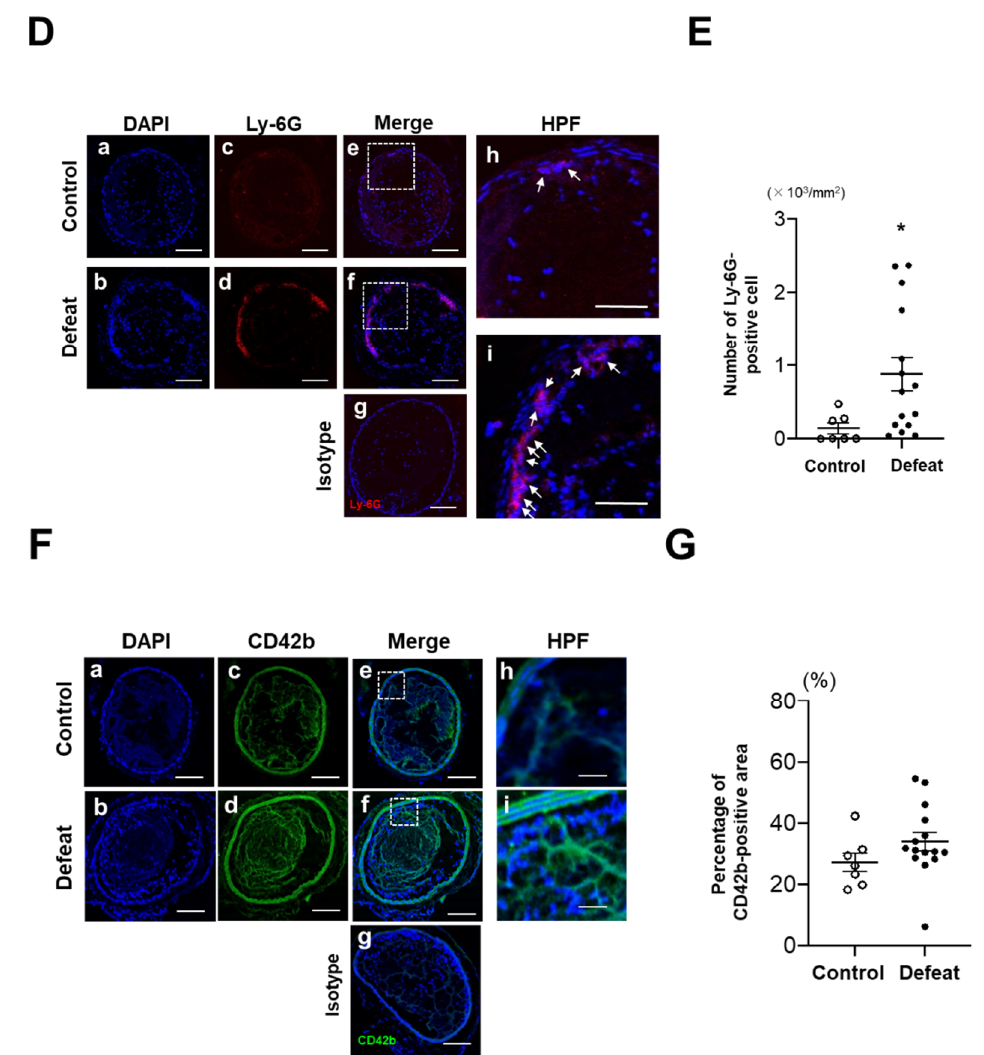
Figure 2. RSD exaggerates the development of fibrin-rich clot formation after FeCl 3 application. ( A ) Representative photographs of hematoxylin and eosin staining in control and defeated mice. Scale bar = 100 μm ( a , b ), 50 μm ( c , d ), and 20 μm ( e , f ). High magnification images ( e , f ) showing the area surrounded by a broken line in panel c , d , respectively. LPF, low-power field; HPF, high-power field. ( B , C ) Representative fluorescent images of fibrin(ogen) and quantitative analysis of the percentage of fibrin(ogen)-positive area. Scale bar = 100 μm ( a – g ) and 50 μm ( h , i ). High-magnification images ( h , i ) showing the area surrounded by a broken line in panel e , f , respectively. Values represent mean ± standard error of mean (SEM) for 7 control mice and 15 defeated mice. ** p < 0.01 vs. control mice; Mann–Whitney test. HPF, high-power field. ( D , E ) Representative fluorescent images of Ly-6G and quantitative analysis of the number of Ly-6G-positive cells. Scale bar = 100 μm ( a – g ) and 50 μm ( h , i ). High-magnification images ( h , i ) showing the area surrounded by a broken line in panel e,f , respec- tively. Arrows indicate Ly-6G-positive cells. Values represent mean ± standard error of mean (SEM) for 7 control mice and 15 defeated mice. * p < 0.05 vs. control mice; Mann–Whitney test. HPF, high power field. ( F , G ) Representative fluorescent images of CD42b and quantitative analysis of the per- centage of CD42b-positive area. Scale bar = 100 μm ( a – g ) and 20 μm ( h , i ). High-magnification im- ages ( h , i ) showing the area surrounded by a broken line in panel e , f , respectively. Values represent mean ± standard error of mean (SEM) for 7 control mice and 15 defeated mice. HPF, high-power field.